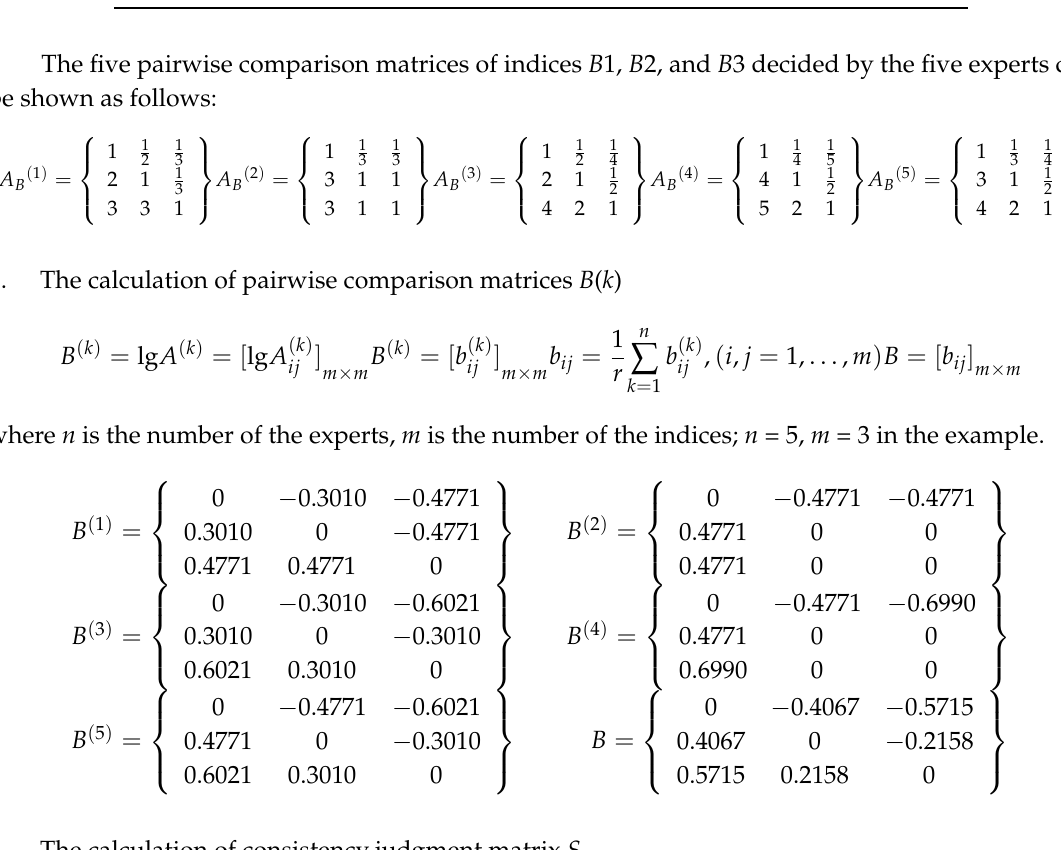
Reciprocals for inverse